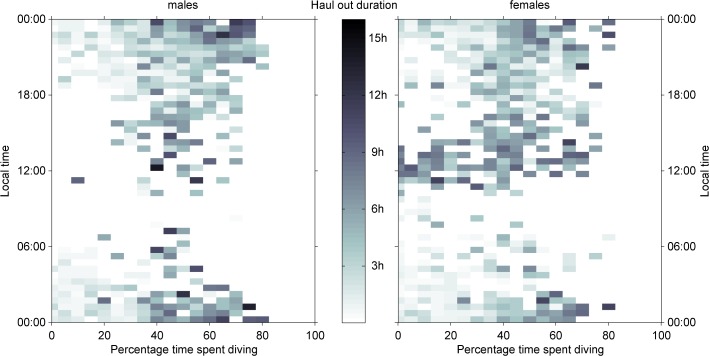
Timing of haul-out event vs. diving effort.Local time of the centre of haul-out events in relation to the diving effort preceding that event, as defined in the text (Tm vs Td) for males (left) and females (right). Only boxes with at least 2 haul-outs are shown. The darker the colour of the grid cell the longer the average haul-out duration corresponding to that percentage of diving.